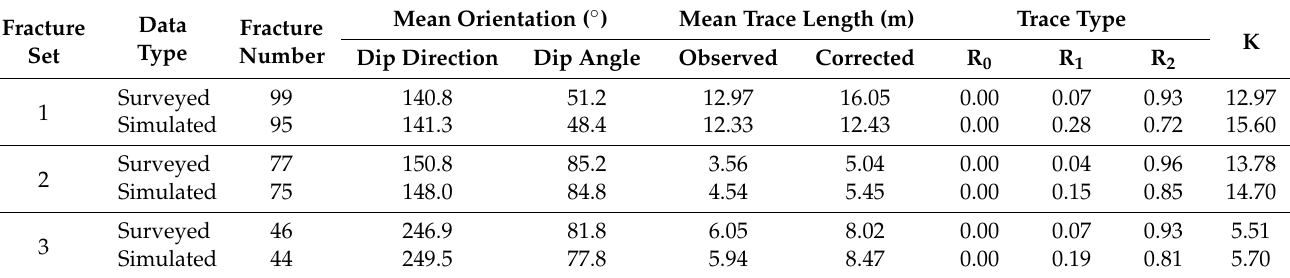
Table 2. The validation of the optimal model by comparing the surveyed data and simulated